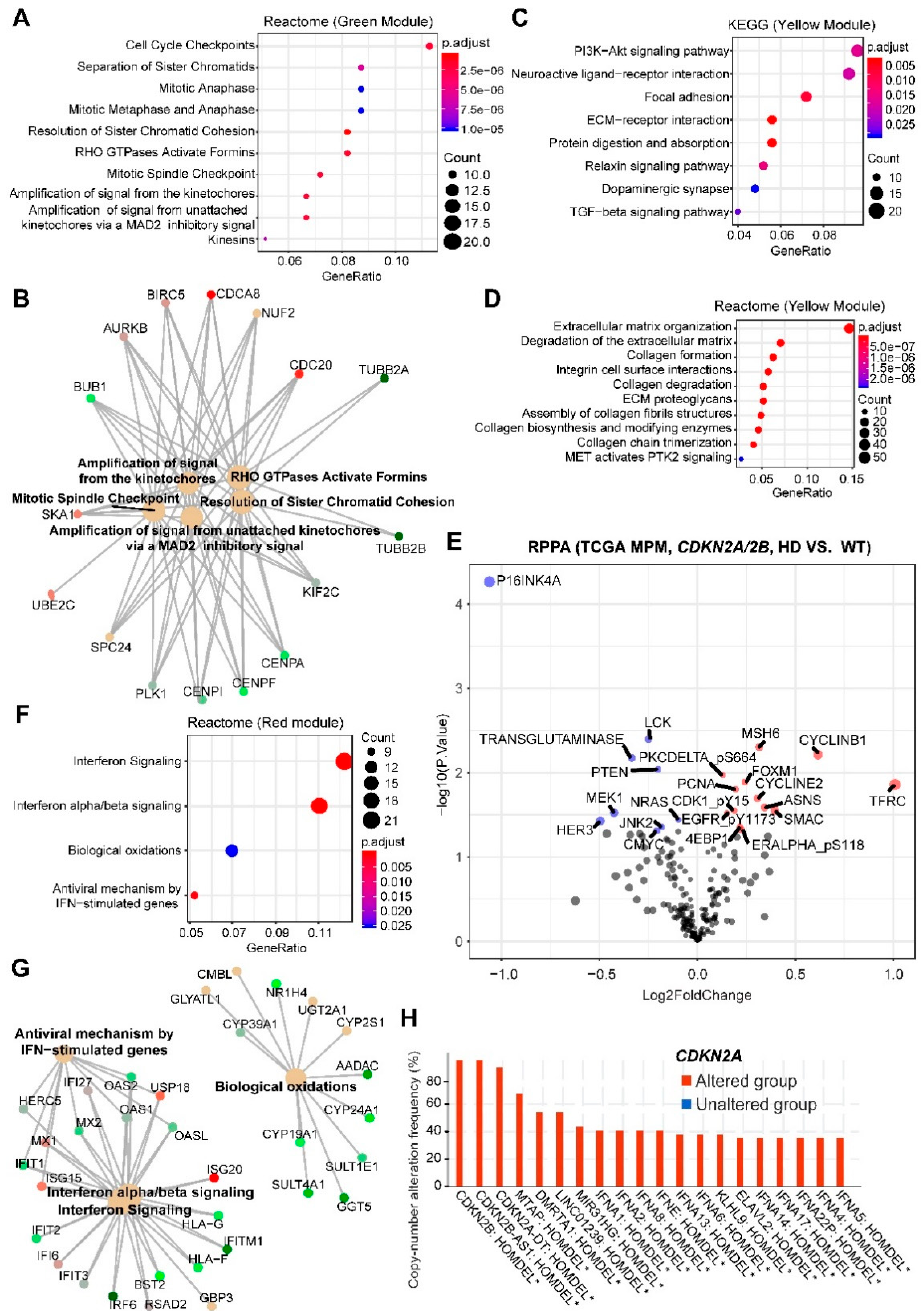
Figure 2. Enrichment analyses of genes significantly correlated with MPM tumors harboring HDs in CDKN2A/2B . ( A , B ), Top 10 significantly enriched Reactome pathways based on genes in the green module. In B, genes in the enriched Reactome pathways were listed. ( C , D ), Top 10 significantly enriched Kyoto Encyclopedia of Genes and Genomes (KEGG) ( C ) and Reactome ( D ) pathways based on genes in the yellow module. ( E ), Volcano plot showing the significantly (adjusted p -value < 0.05) upregulated (red) and downregulated (blue) proteins in malignant pleural mesothelioma (MPM) tumors harboring homozygous deletions (HDs) in CDKN2A/2B (versus wild-type), based on The Cancer Genome Atlas (TCGA) MPM cohort ( N = 61). Data were downloaded and reanalyzed from The Cancer Proteome Atlas (TCPA) database (https://tcpaportal.org/tcpa/). ( F , G ), significantly enriched Reactome pathways based on genes in the red module. In ( G ), genes in the enriched Reactome pathways ( F ) were listed. ( H ), Genes significantly co-deleted with CDKN2A/2B in TCGA MPM samples. Data were downloaded from cBioPortal (https://www.cbioportal.org/). * p < 0.05. 2.3. BAP1.